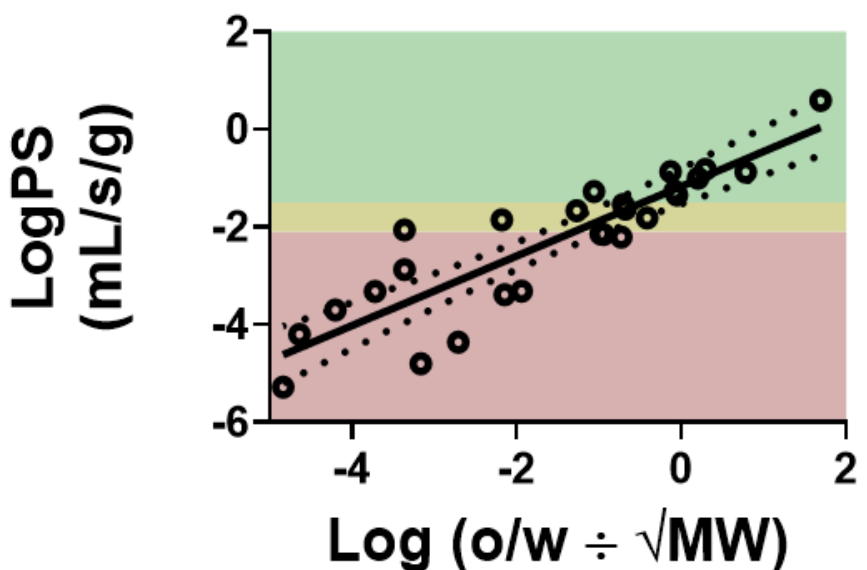
Figure 2. Correlation of solute BBB permeability, indicated by its permeability surface area (PS) √ product, with the Log(P ÷ MW). Compounds with higher lipophilicity have a greater tendency